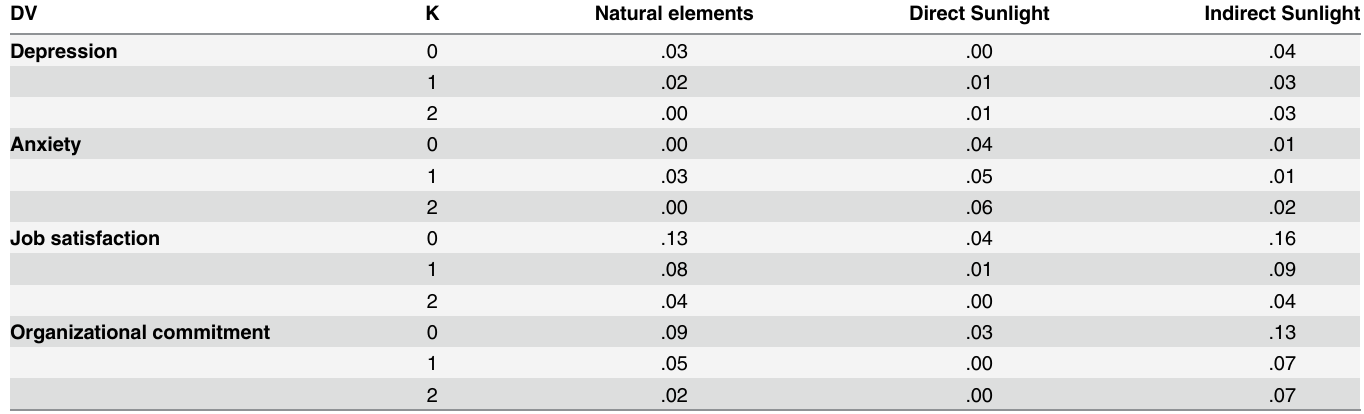
Table 7. Dominance analysis: average R 2 Values.